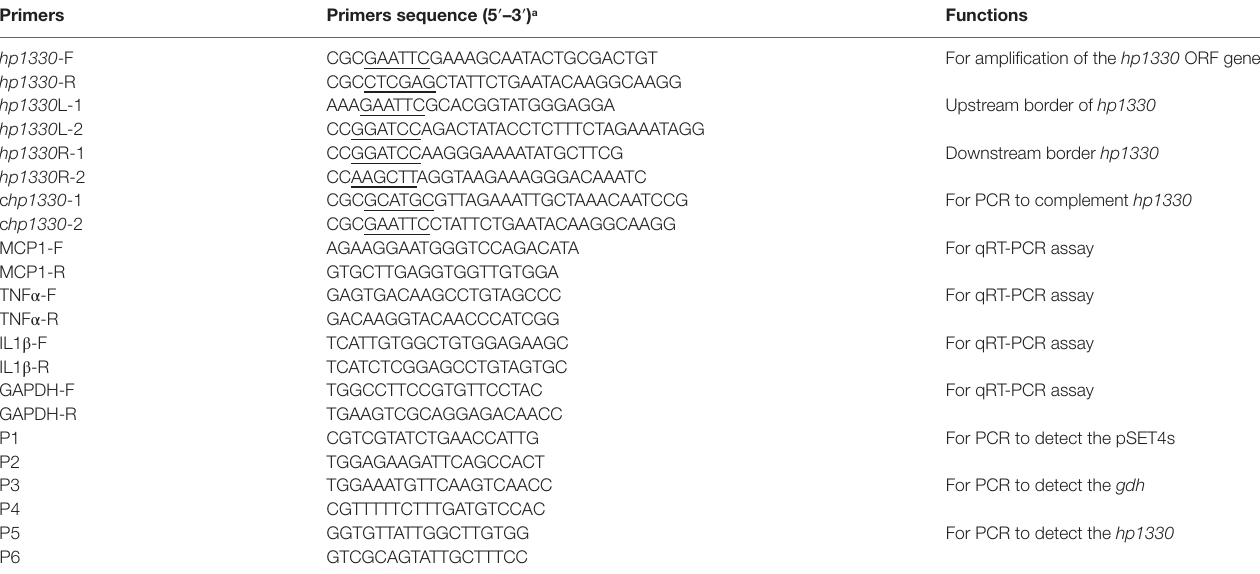
Table 2 | Oligonucleotide primers used in this study.